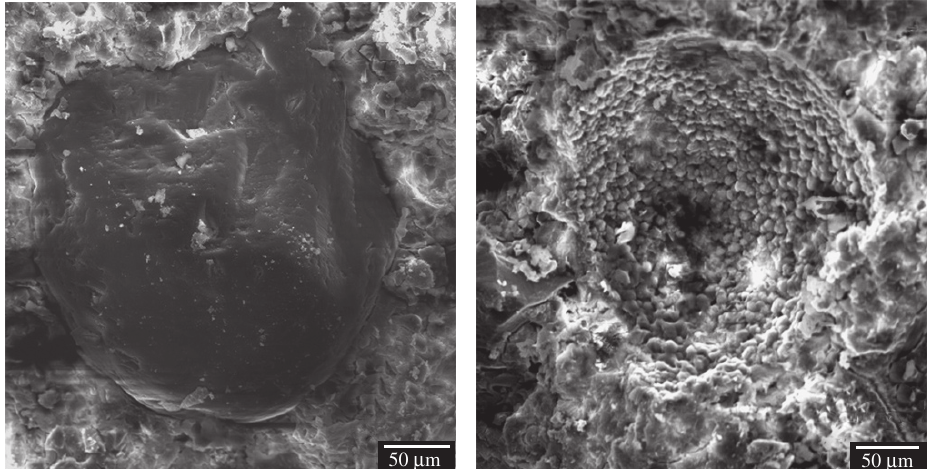
Figure 9. SEM micrographs: a) sand grain dispersed in magnesium phosphate mortar matrix; and b) MgO grains agglomerated in a region near a sand